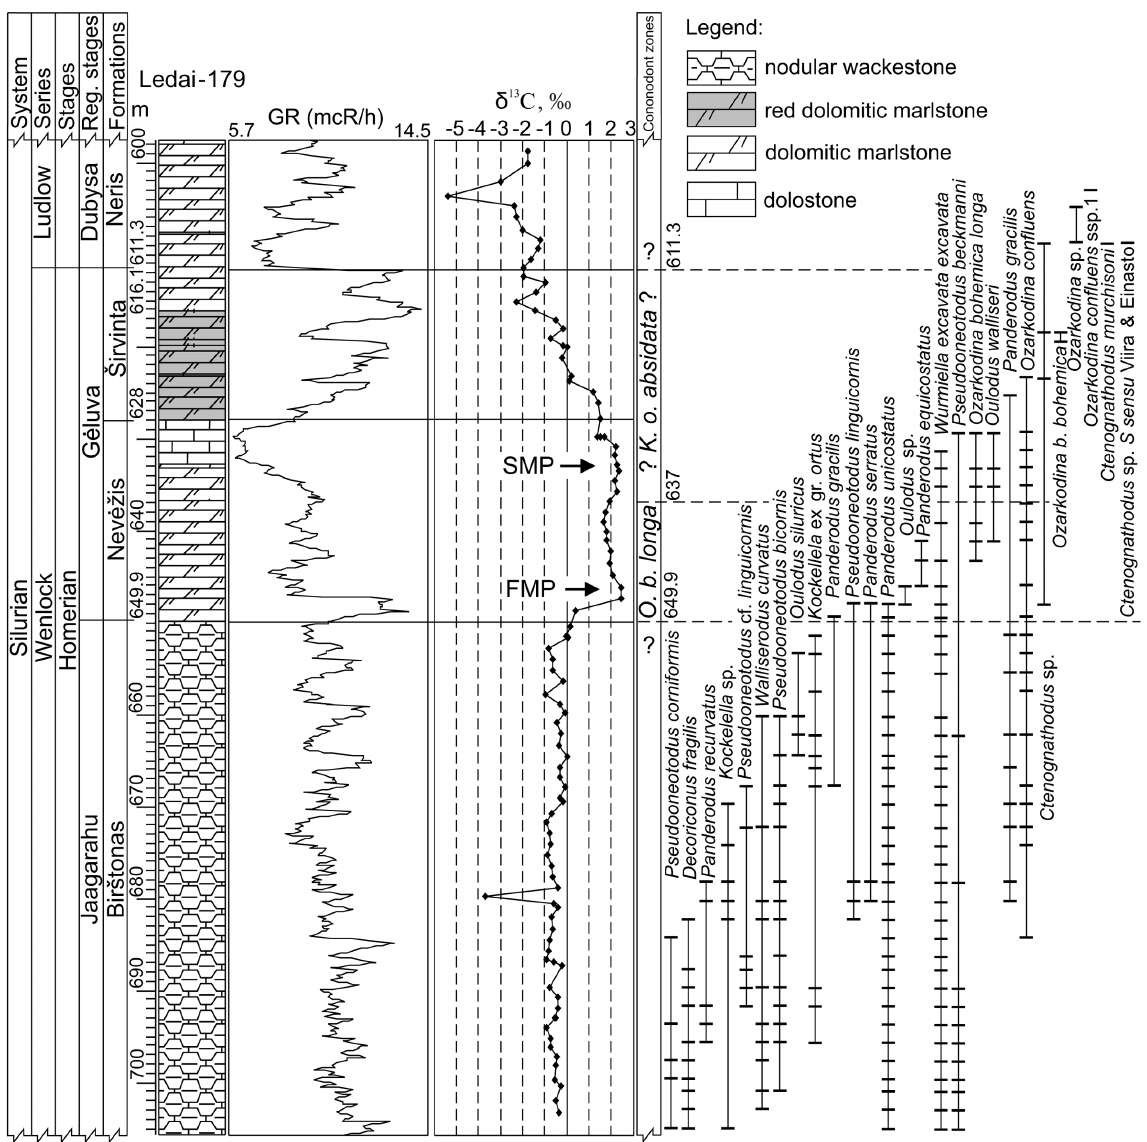
Fig. 2. Lithologies, gamma ray log, stable carbon isotopic curve and conodont distribution in the studied interval of the Ledai-179 core. FMP, first Mulde peak; SMP, second Mulde